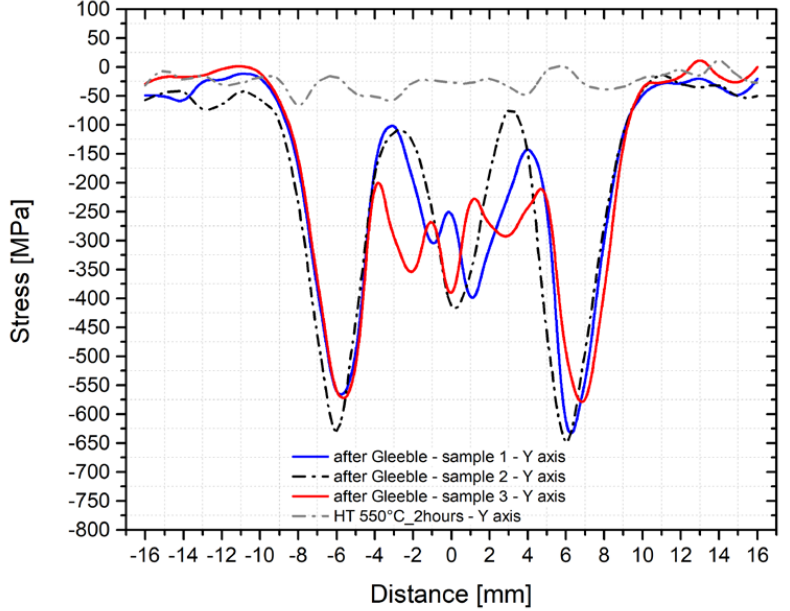
Figure 13. Course of the transverse residual stresses along the Y-axis after the application of the temperature cycle (three samples annealed at a temperature of 550 °C for 2 h).